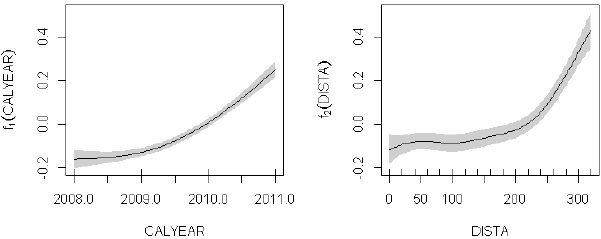
Figure 8 1107 Fig. 8. Nonlinear effects of the calendar year (CALYEAR), and dis- tance from grid-row A (DISTA), on the laser-scanned vegetation height (VEGHEIGHT) (see Eq. 16). Shaded: 95%-confidence